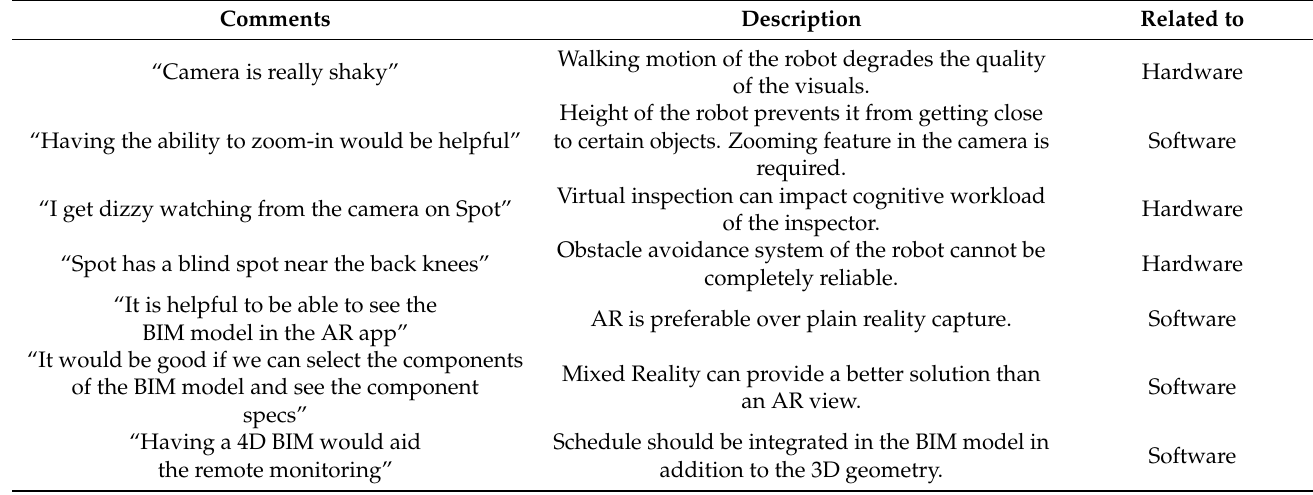
Figure 13. Live 360 ◦ panoramic image from the 360 ◦ camera installed on the robot. Figure 13. Live 360° panoramic image from the 360° camera installed on the robot. Table 1. Challenges and recommendations from use case 1 Table 1. Challenges and recommendations from use case 1 experiment.